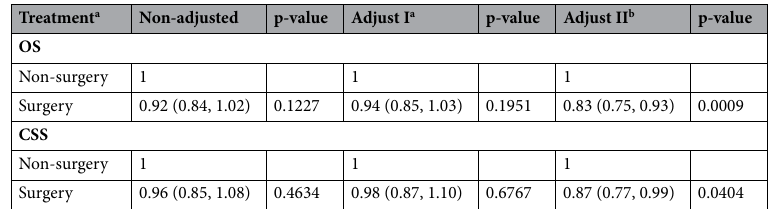
Table 3. Multivariable Analysis of OS and CSS in Non-surgery group and surgery group. OS overall survival, CSS cancer specific survival. a There were 2041 and 1496 patients in unmatched surgery and non-surgery groups, respectively. b Adjust I model of P values adjusted for age, gender, race and marital status. c Adjust II model of P values adjusted for age, gender, race, marital status, year of diagnosis, Ann Arbor Stage, histologic, tumor site and radiation.